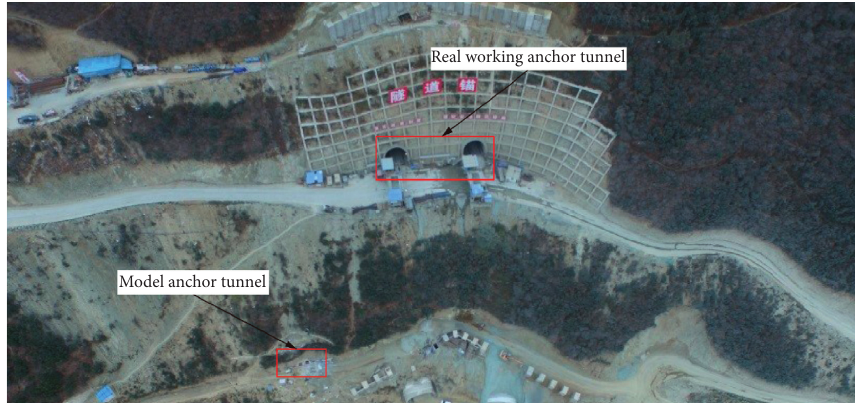
Figure 3: Locations of model anchor and real working anchor tunnels.